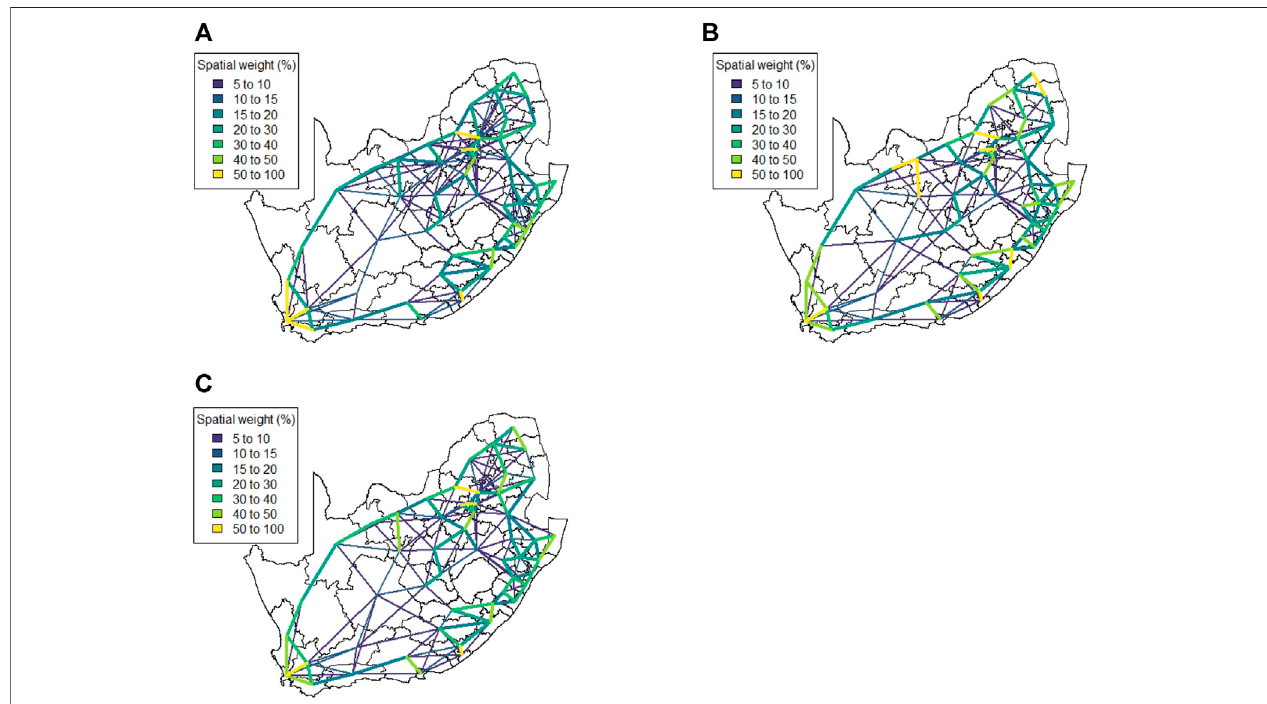
FIGURE 7 | Method 2 spatial weight matrix entries (weights ≤ 5 not shown) (A) Business as usual, (B) Level 5, (C) Level 4 at district municipality level.